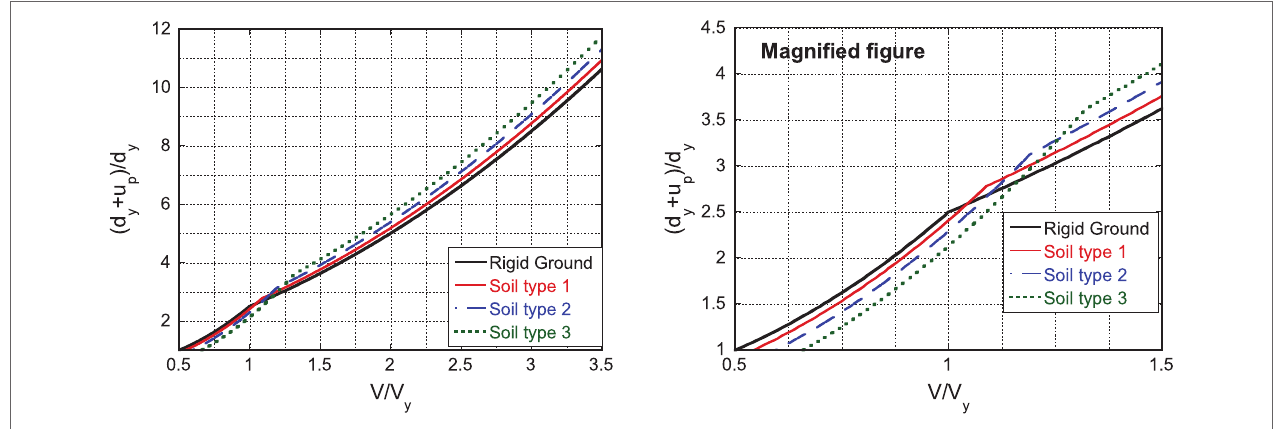
FigUre 9 | relation of the maximum plastic deformation ( d y + u p )/ d y with V / V y for three soil conditions and fixed-base